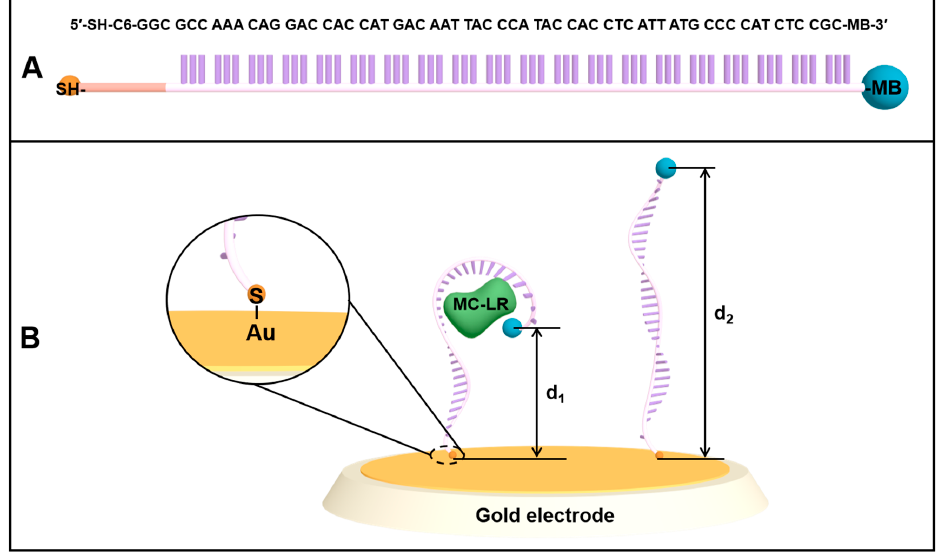
Figure 1. Schematic illustration of the fabrication steps of the sensor. ( A ) The thiolated and methylene blue (MB) − modified aptamer (5 ′− SH − C6-GGC GCC AAA CAG GAC CAC CAT GAC AAT TAC CCA TAC CAC CTC ATT ATG CCC CAT CTC CGC − MB − 3 ′ ) for MC − LR; ( B ) The aptamer labeled with a methylene blue (MB) group at the 3 ′− terminus of the aptamer is immobilized on a gold electrode surface through the gold-sulfur chemistry. In the absence of target MC − LR, the MB tag at the 3 ′− terminus demonstrates low ET efficiency due to the possible interaction with aptamer bases or a relatively large distance from the electrode surface. The addition of MC − LR induces the conformational change of aptamer, which results in alterations in the local environment of MB, interactions between MB and aptamer bases, and the distance of MB to the electrode surface, bringing MB closer to the electrode surface and thus, enhancing ET efficiency.